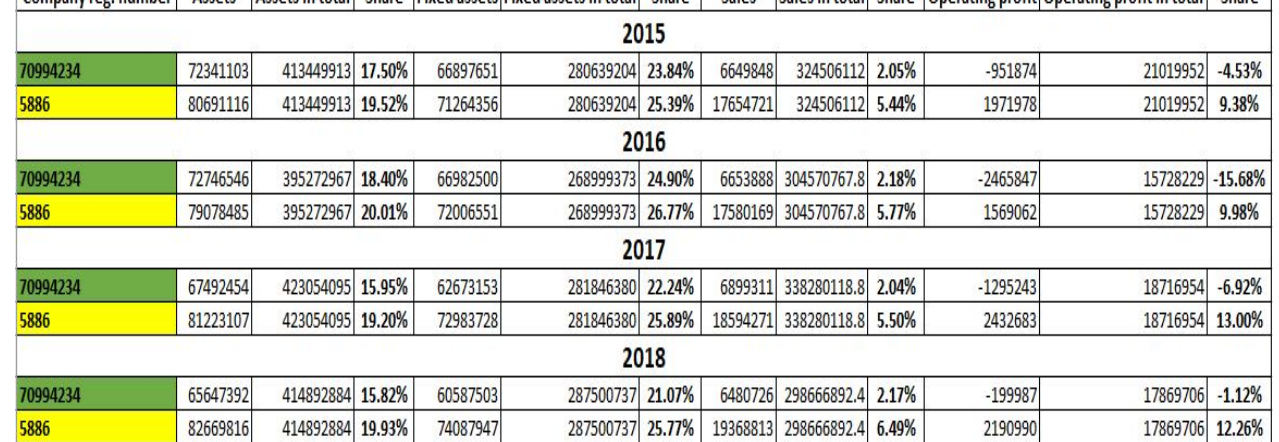
Figure 4. Participation of selected companies on the creation of individual components. Source: Author.